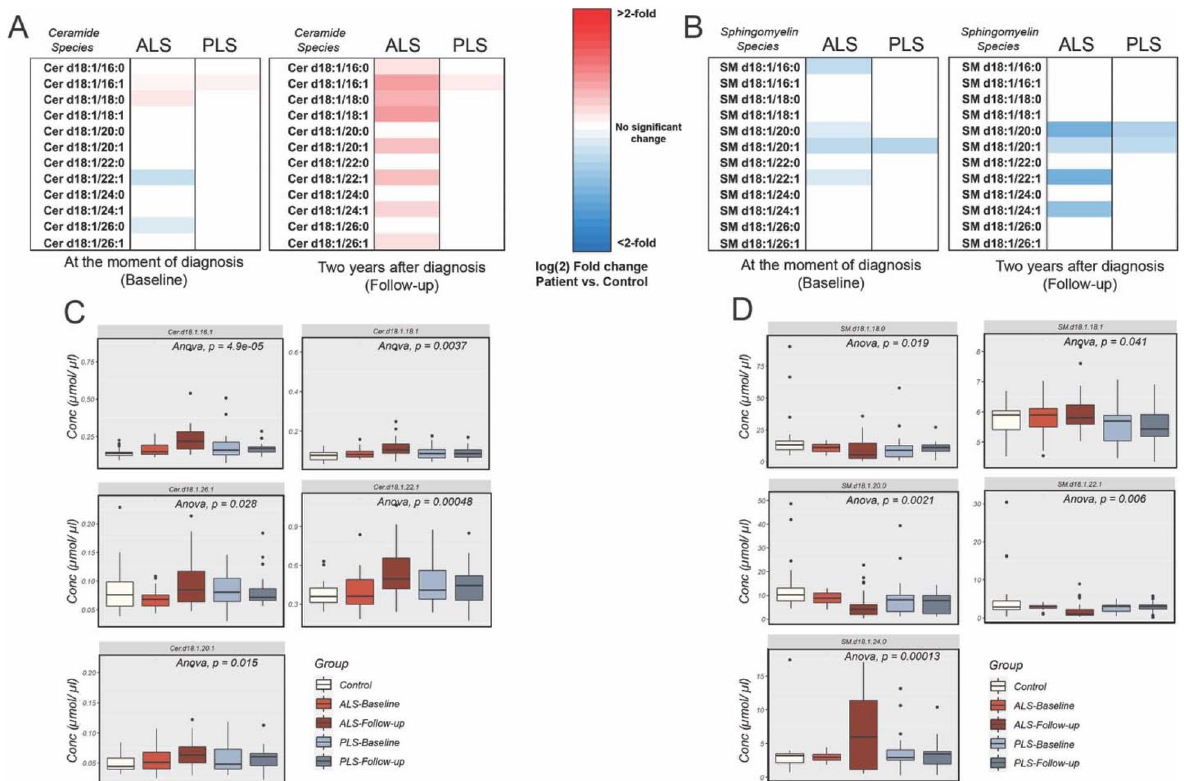
Figure 6. Analysis of ceramide (Cer) and sphingomyelin (SM) changes in plasma from ALS and PLS patients compared to controls ( A ) Heat map representation of the most significant fold-changes in the concentration of ( A ) ceramide and ( B ) sphingomyelin species in plasma from ALS and PLS patients compared to controls at the beginning of the study (baseline) and 2 years after (Follow-up). Graph representations of the average concentration of ( C ) ceramide and ( D ) sphingomyelin species in ALS and PLS plasma. One-way ANOVA. P values are indicated (n = 40 ALS, 26 PLS samples and 28 controls analyzed in triplicate. *< 0.05; **<